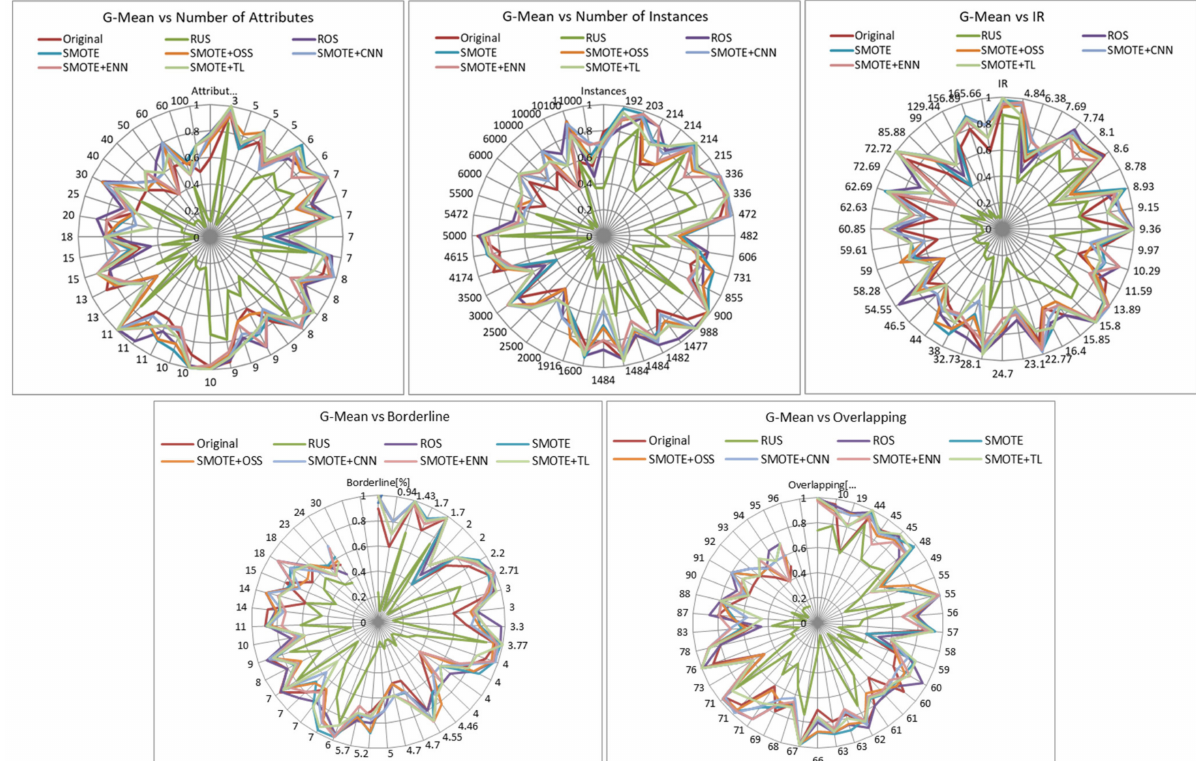
Figure 6. Influence of dataset characteristics on G-mean for all resampling